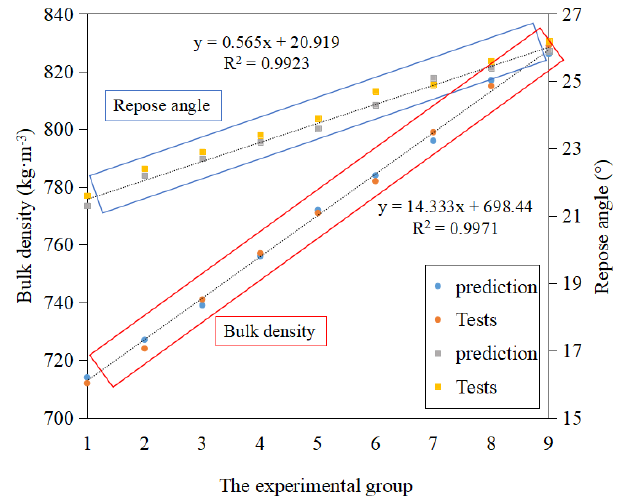
Figure 15. Comparison results of measured and predicted accumulation.